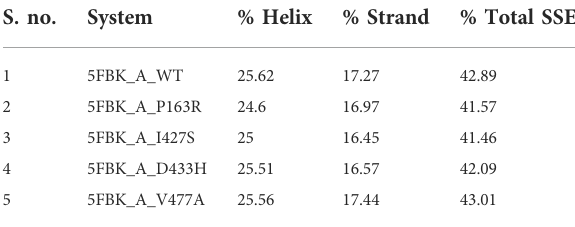
TABLE 3 Average protein secondary structure elements throughout the simulation.